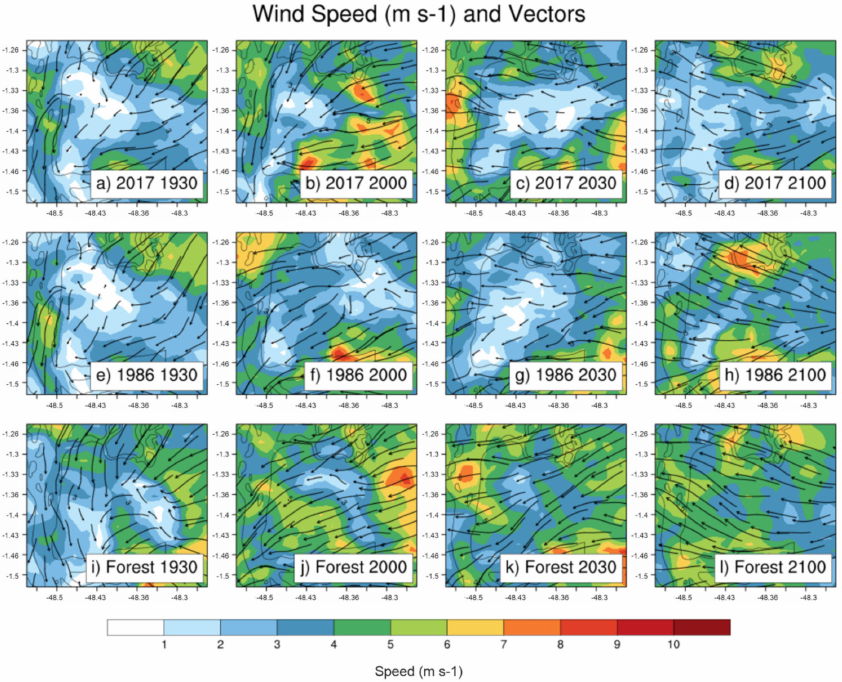
Figure 16. Wind vector fields near the surface for each scenario at 1930, 2000, 2030, and 2100